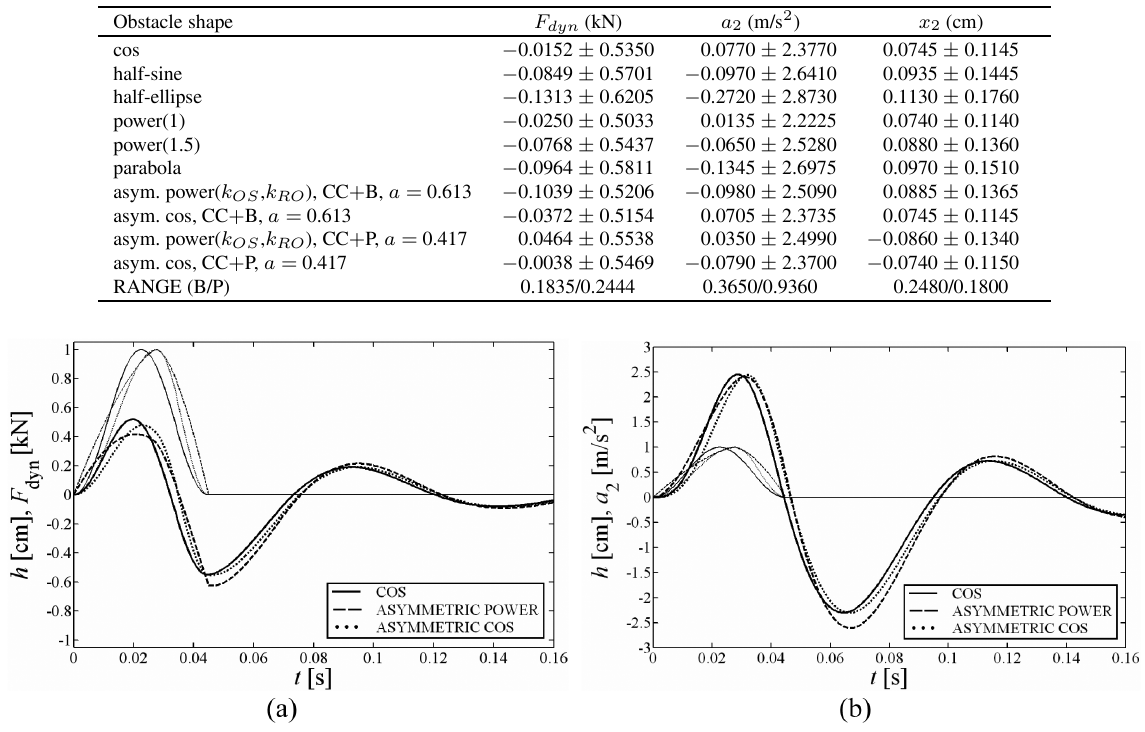
Table 6 Statistics of quarter-car model vibration response to different obstacle shapes in terms MEAN ± HVR